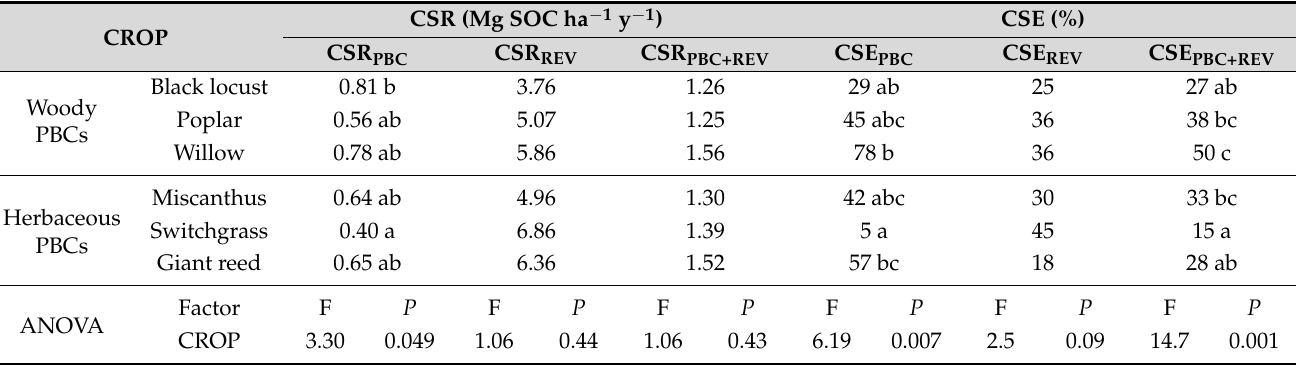
Table 4. Carbon sequestration rates (CSR, Mg SOC ha − 1 y − 1 ) and carbon sequestration efficiency (CSE, %) considering the cultivation period (11 years of PBC cultivation—CSR PBC ), reversion phase (2 years of annual crop cycle after reversion—CSR REV ), and whole cultivation period (CSR PBC+REV ). Different letters within the same column indicate significant differences ( p < 0.05) among crops, according to Tukey’s